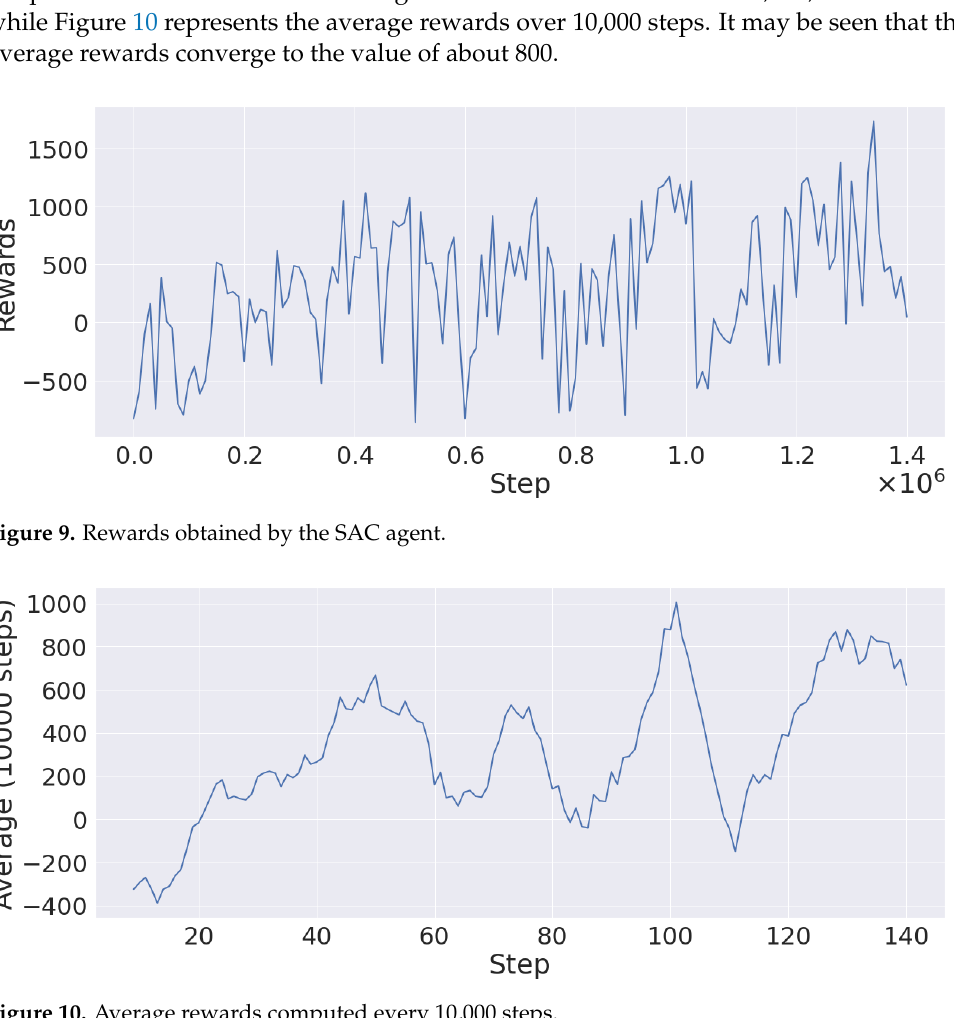
Figure 10. Average rewards computed every 10,000